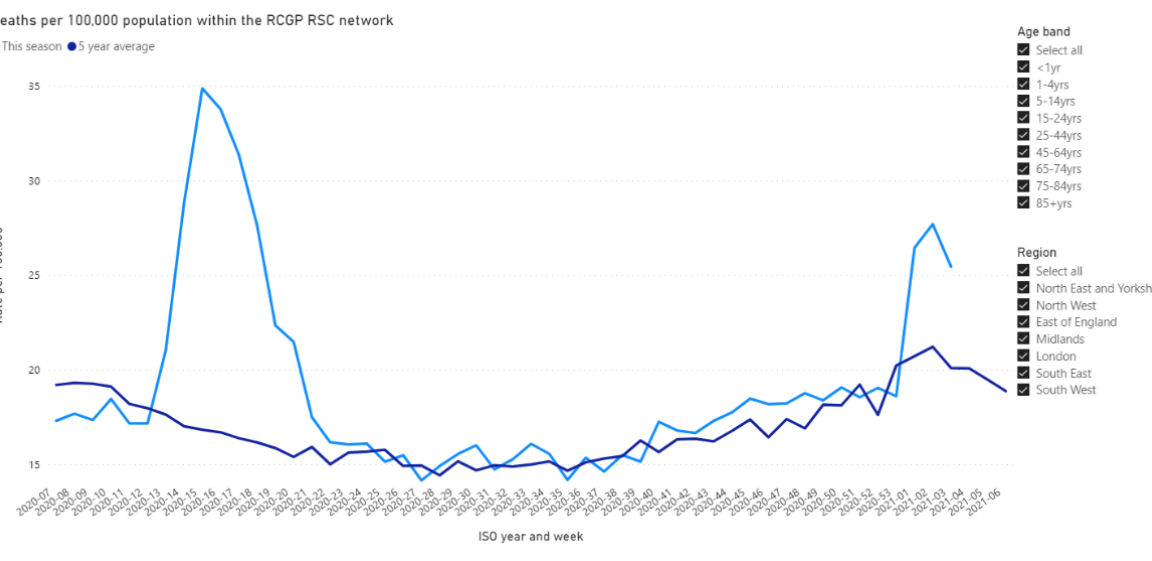
Figure 2. Royal College of General Practitioners Research and Surveillance Centre observatory showing mortality through the first wave of the COVID-19 pandemic in England. Deaths per 100,000 population are displayed over the International Organization for Standardization (ISO) weeks for 2019 and